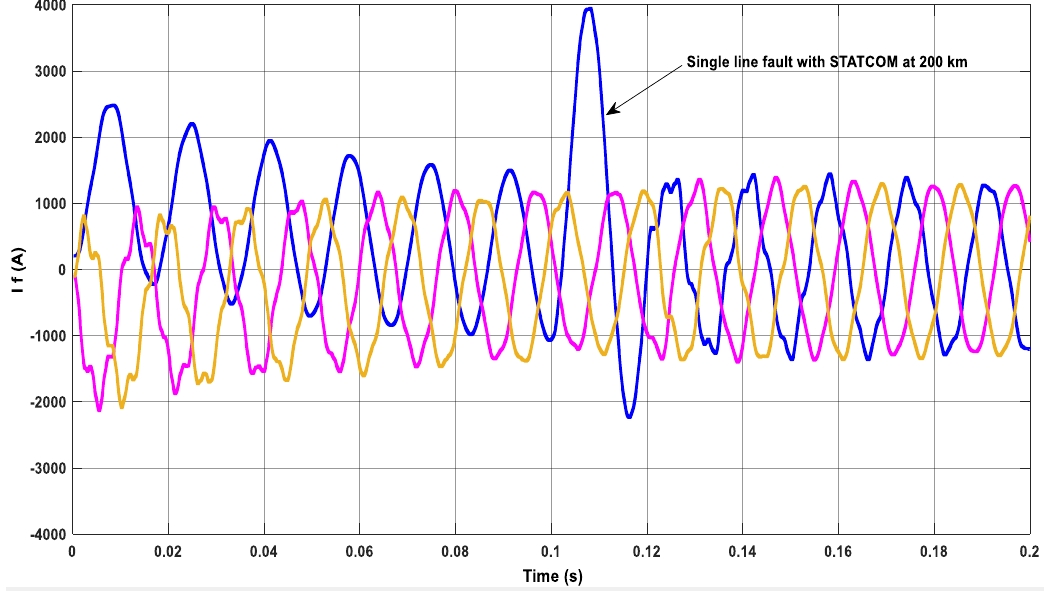
Figure 9. Three-phase current waveform during the LG fault (at 200 km) in Phase A with STATCOM